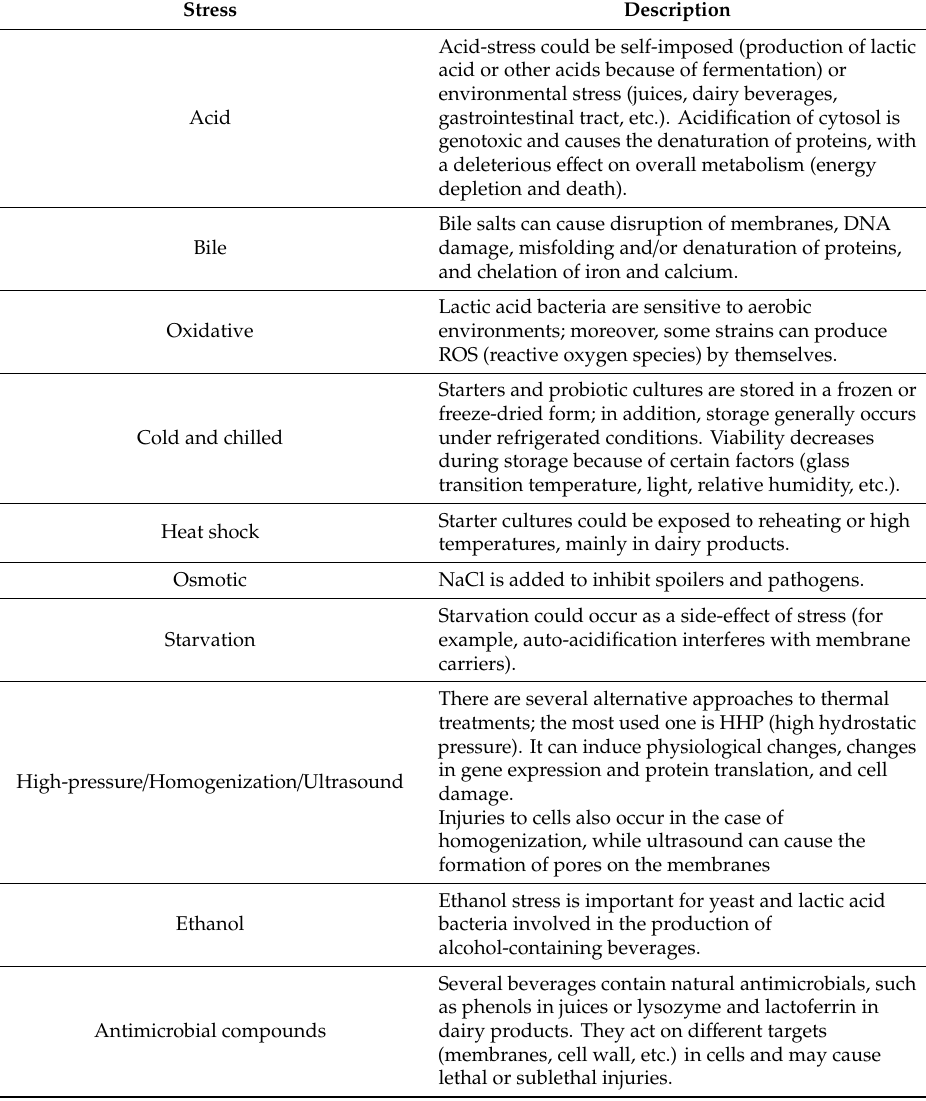
Table 1. Stresses encountered by food-grade microorganisms during food production and storage